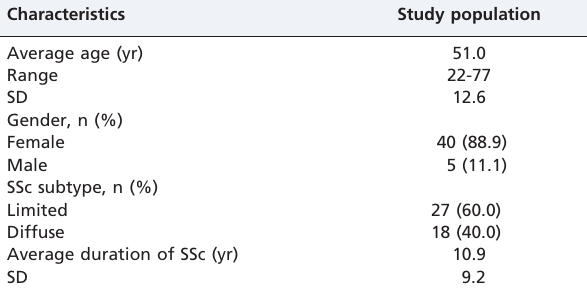
Table 1 - Demographic features of the study